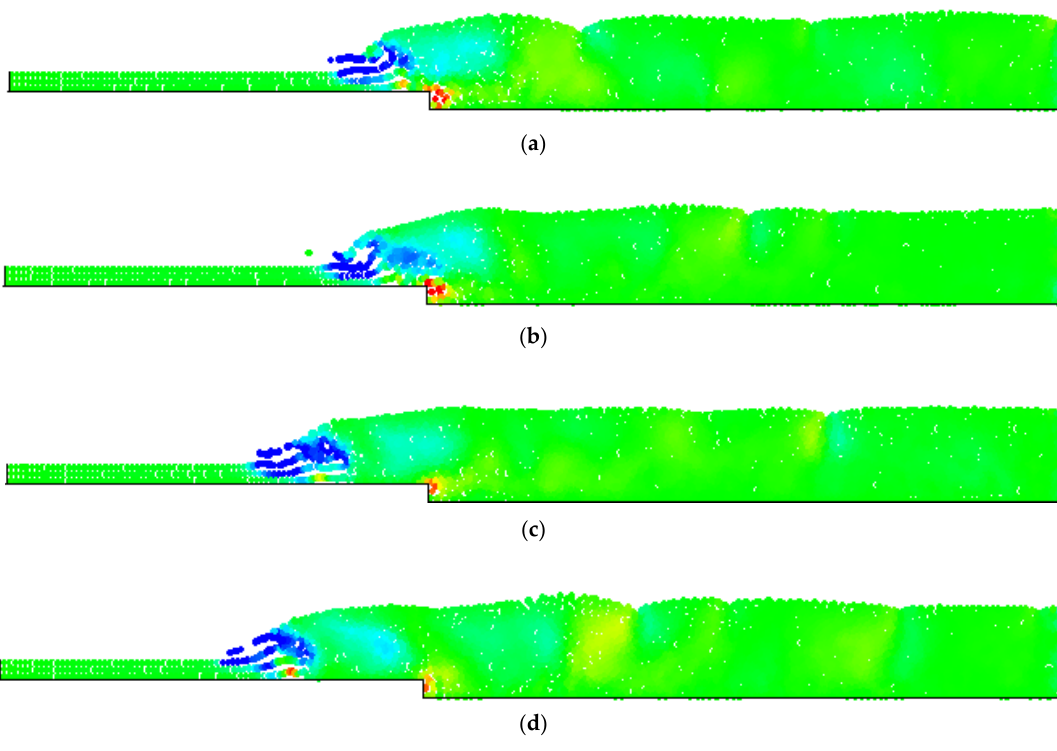
Figure 10. Instantaneous SPH vorticity field in the SPH simulation of Test T4: ( a ) t = 15 s; ( b ) t = 18 s; ( c ) t = 22 s; and ( d ) t = 24 s. Colour scale is the same as in Figure 7.